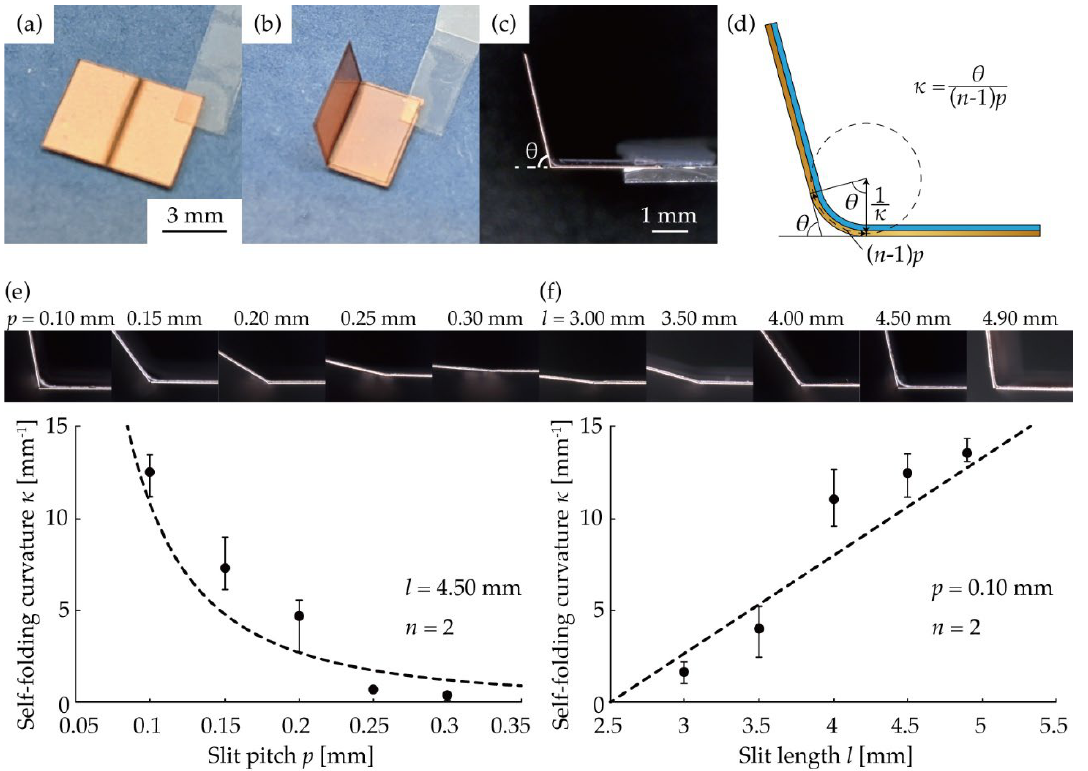
Figure 3. Evaluation of the self-folding curvature. ( a ) Specimen before self-folding. ( b ) Specimen after self-folding. ( c ) Specimen after self-folding observed from the side. ( d ) Measurement method of the self-folding curvature. ( e ) Relationship between the slit pitch p and the self-folding curvature κ . (Number of slits n = 2 and slit length l = 4.50 mm.) ( f ) Relationship between the slit length l and the self-folding curvature κ . (Number of slits n = 2 and the slit pitch p = 0.10 mm).